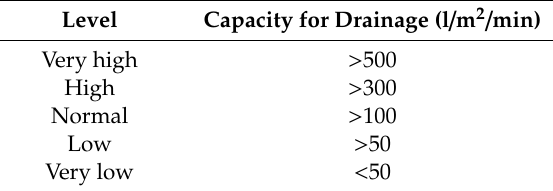
Table 2. Capacity for